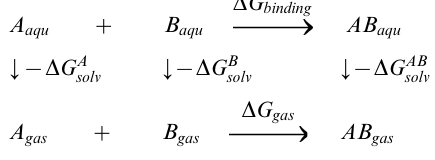
Figure S1 Comparison of patterns derived from different protein loading between the Double-Strips and Single-Strip BN/ SDS PAGE. D1-1 , D1-4: The pattern of Double-Strips BN/SDS- PAGE with two 1D BN-Gel strips. S2-1 , S2-4: The pattern of Single-Strip BN/SDS-PAGE with one 1D BN-Gel strip. Each strip excised from 1D BN-Gel lane loaded with 50 m g chlorophyll and the membrane dissolved at DDM/protein ratio of 4/1. Each set of experiment was repeated four times. (TIF) Figure S2 Comparison of patterns derived from equal protein loading between the Double-Strips and Single-Strip BN/SDS PAGE. D1-1 , D1-4: The patterns of Double-Strips BN/SDS- PAGE with two 1D BN-Gel strips each loaded with 50 m g chlorophyll dissolved at DDM/protein ratio of 4/1. S1-1 , S1- 4: The patterns of Single-Strip BN/SDS-PAGE with one 1D BN-Gel strip loaded with 100 m g chlorophyll dissolved at DDM/protein ratio of 4/1. S3-1 , S3-4: The patterns of Single-Strip BN/SDS- PAGE with one 1D BN-Gel strip loaded with 100 m g chlorophyll dissolved at DDM/protein ratio of 2/1. Each set of experiment was repeated four times. Figure S3 The mass spectra for the proteins identified with the mass cut off by100 ppm listed in the Table 2 of the main text. Table S1 Thylakoid membrane proteins identified from rice ( Oryza sativa L.) by